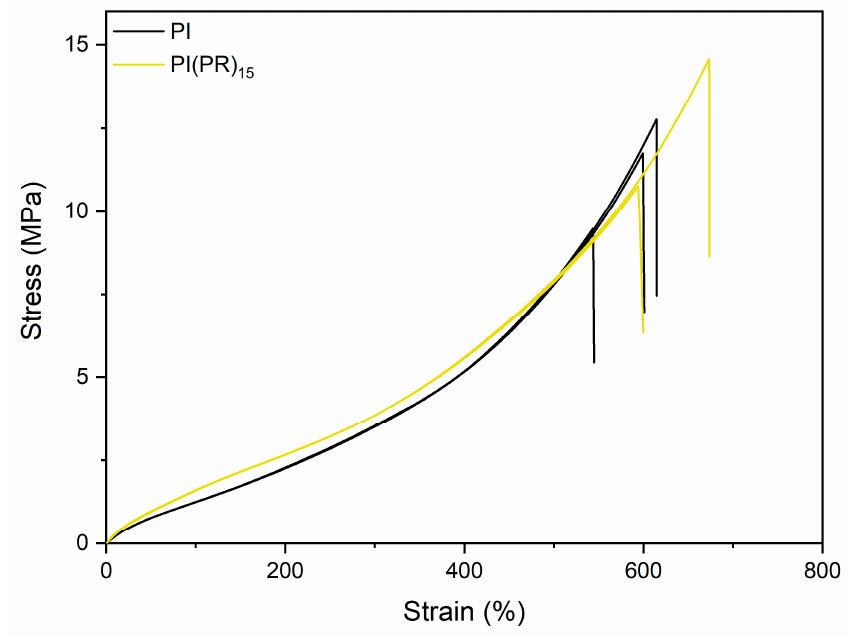
Figure A37. Stress-strain curves of the rubber compounds with phenolic resin and the reference.